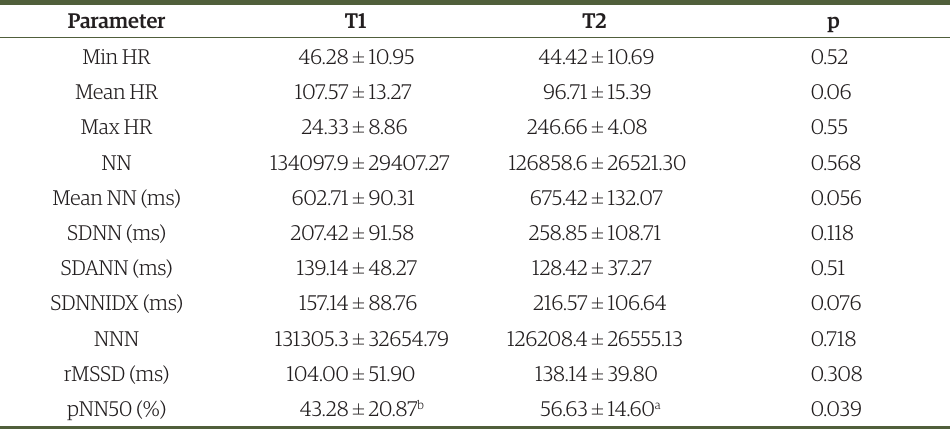
Table 2. Long-term electrocardiography parameters (24-hour Holter) obtained in dogs (n=8) with stage C mitral valve disease before (T1) and 30 days after (T2) initiation of therapy with metoprolol.